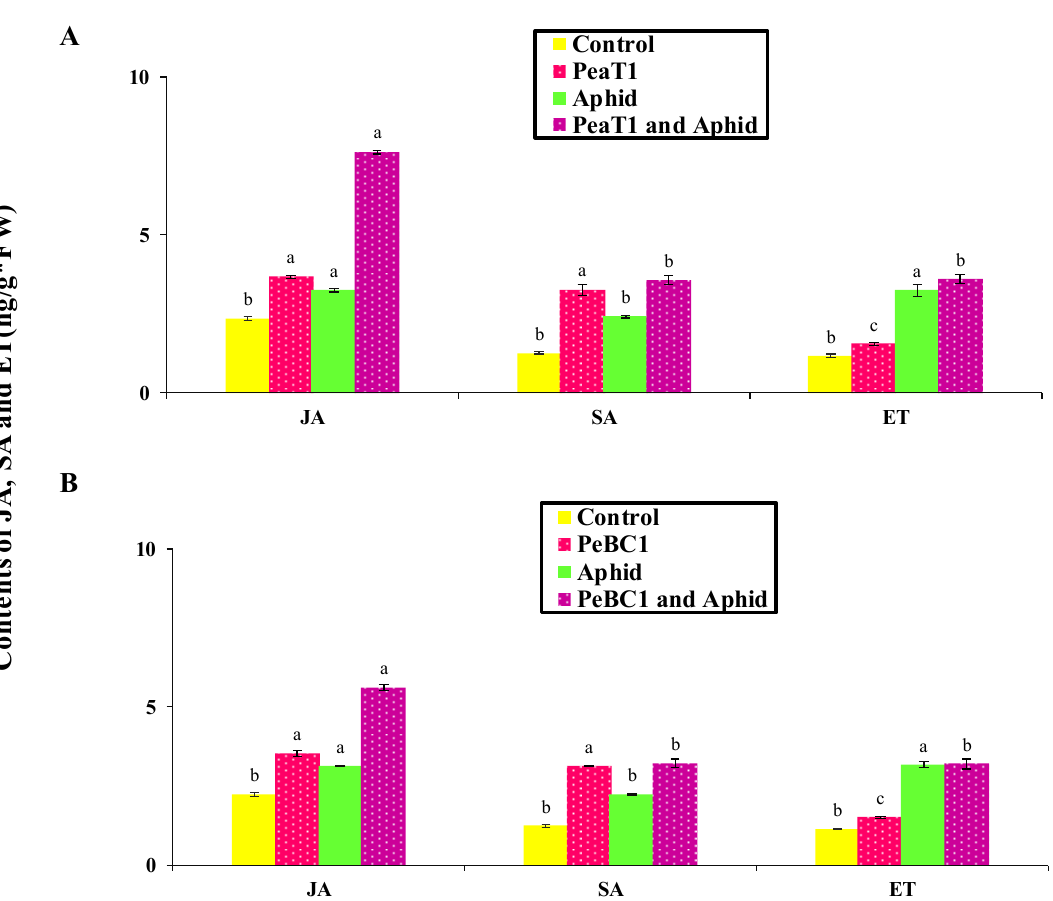
Figure 8. Chili seedlings’ jasmonic acid (JA), salicylic acid (SA), and ethylene (ET) levels (mean ± SD). ( A , B ), respectively. One day after spraying, data on PeaT1 and PeBC1 treatment was collected. The aphids were inoculated one day after seedlings were sprayed in both treatments, and samples were collected one day later. The LSD, ANOVA, and Leven’s test were used to compare data statistically. Version 8.1 of Statistix. Lower-case letters indicate significant differences between various treatments in JA, SA, or ET ( p = 0.05).